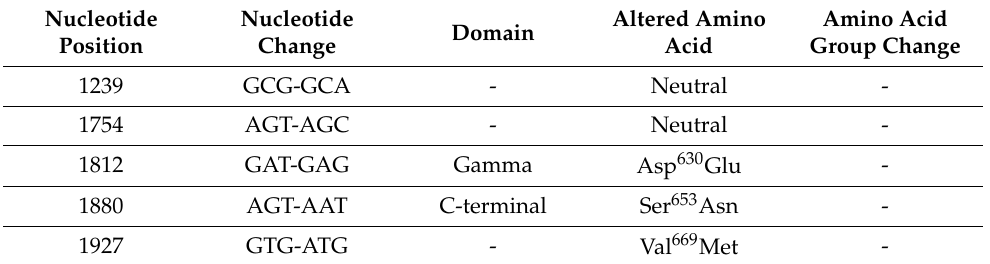
Table 1. Comparison of nucleotide sequences at Position 1880 of the ALS gene between IMI-R, IMI-Ra, IMI-S weedy rice, and CL cultivar. Resistant rice carries the “A” allele and susceptible rice carries the “G” allele. All IMI-R samples show the “A” allele except for the 12 IMI-Ra, which possess the ‘G” allele. IMI-S: IMI-susceptible weedy rice; IMI-R: IMI-resistant weedy rice; CL rice: Clearfield rice; IMI-Ra: IMI-resistant ambiguous weedy rice. Nucleotide Sequences at Positions 1879–1881 Rice Accession IMI-S weedy rice (n = 18); IMI-Ra weedy rice (n = 12): RDA6, RDA4, AGT RKI2, RSK6, RSK9, RTA, RDA4a, RDA5a, RPA4, RTAa, RDE2a, RPC3 Clearfield rice CL2; AAT IMI-R weedy rice (n = 46)